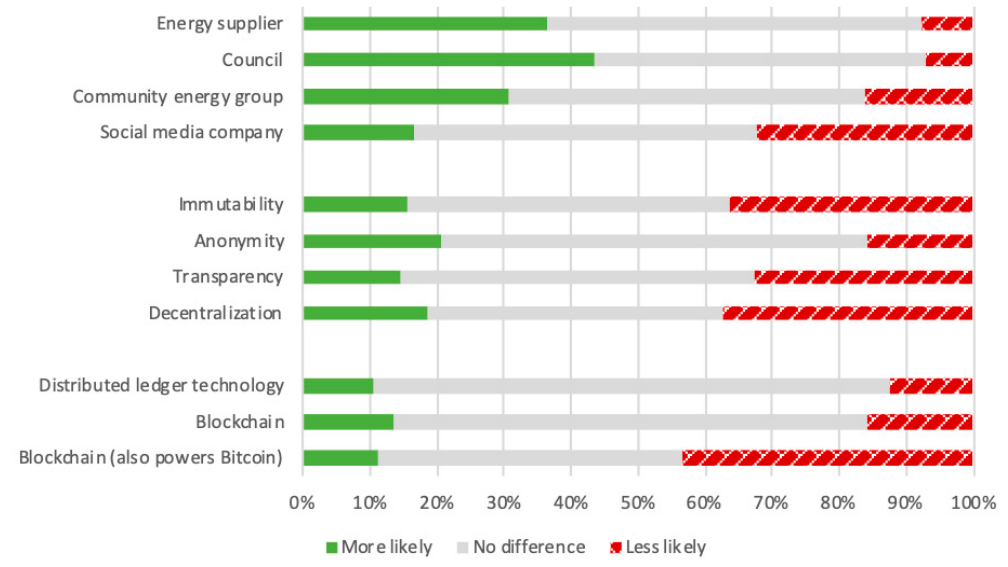
Figure 5. Stated impact on likelihood of uptake in Experiments 2 ( top ), 3 ( middle ) and 4 ( bottom ).